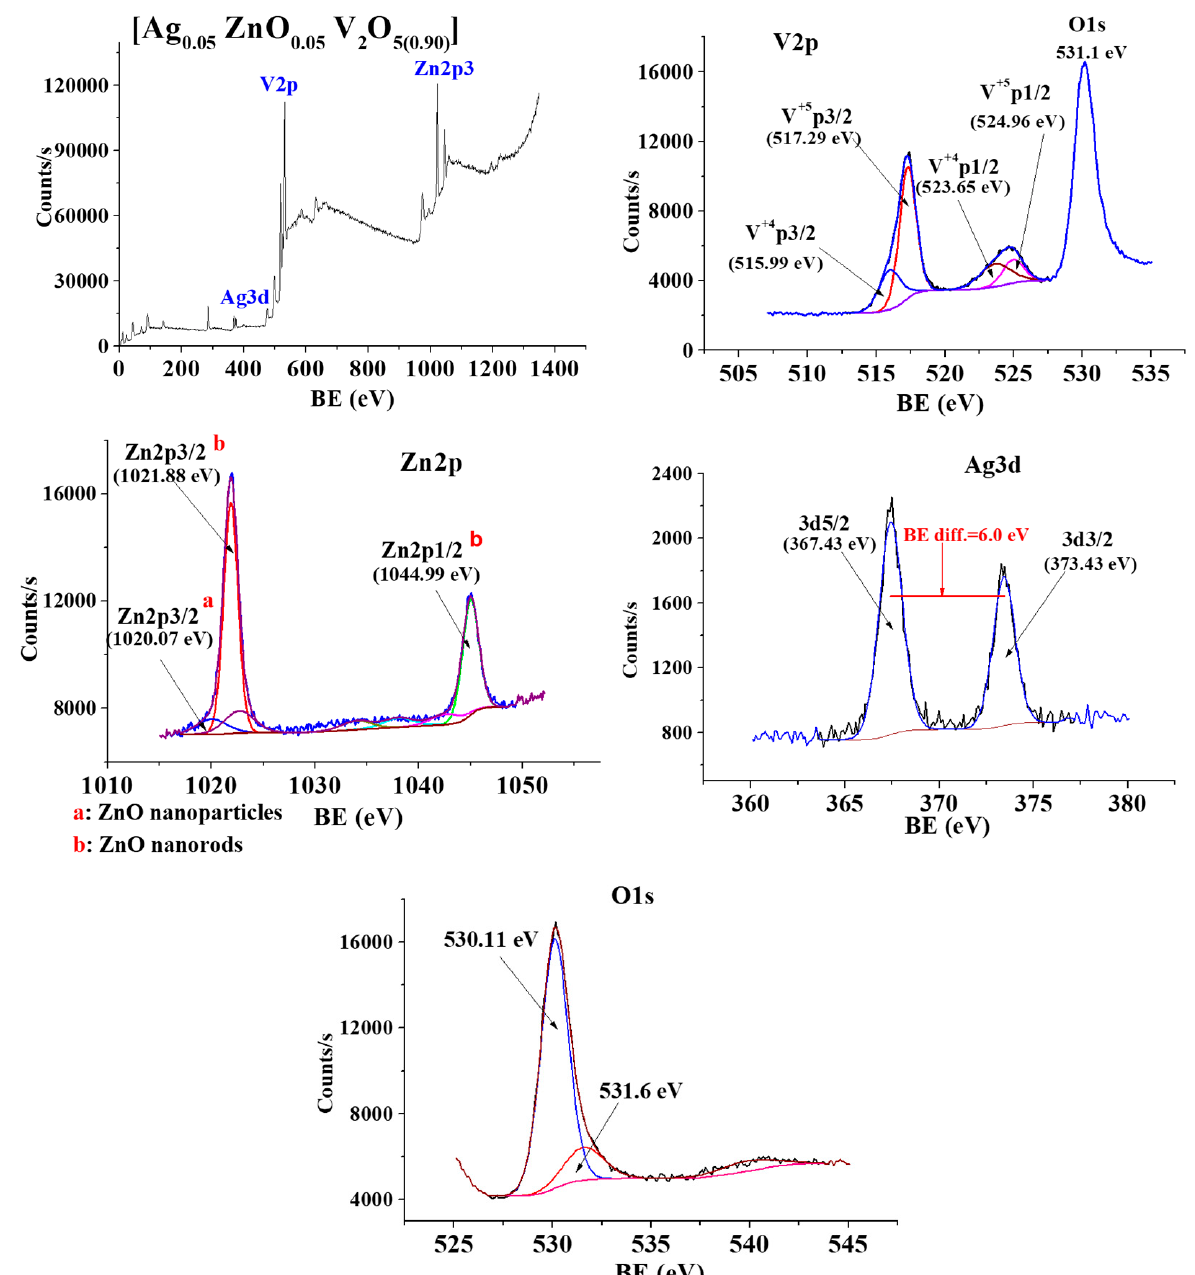
Figure 3. XP-spectra of [Ag 0.05 ZnO 0.05 V 2 O 5(0.90) ] and its constituent metallic species. For [Ag 0.05 ZnO 0.05 V 2 O 5(0.90) ] N , the spectra of V2p as dominant ionic species is